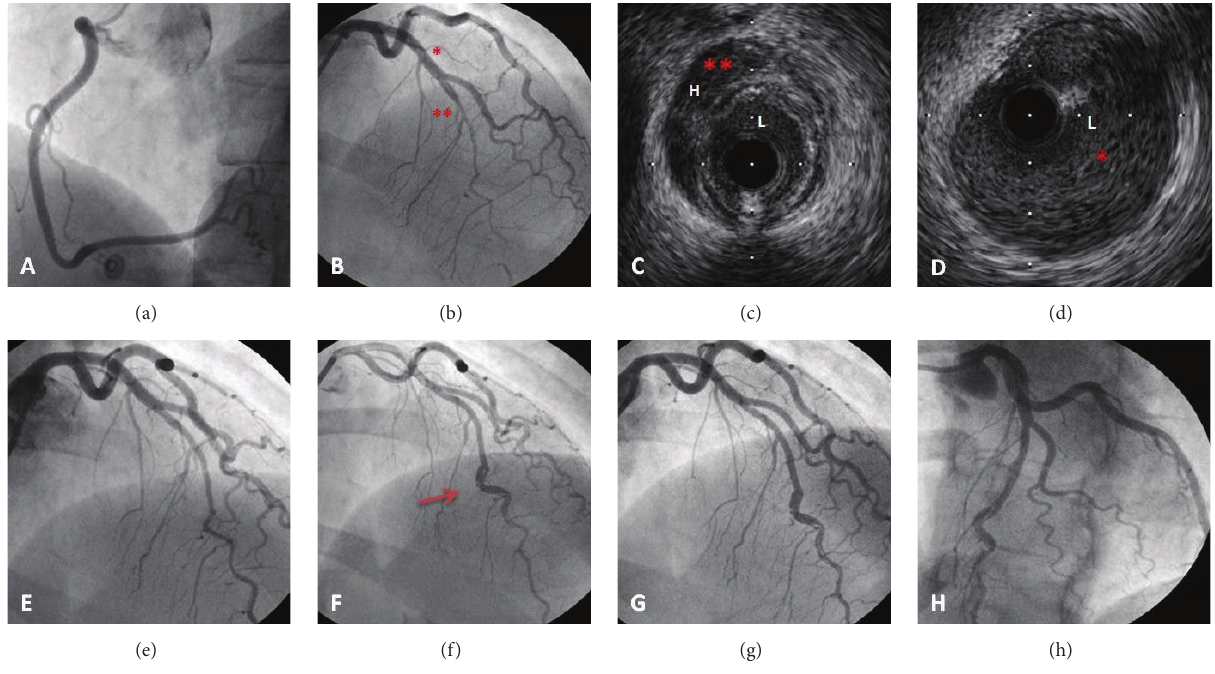
Figure 1: (a) Left anterior oblique (LAO) projection showing a favourable angiographic appearance of the RCA. (b) Right anterior oblique (RAO) cranial projection showing a long tubular stenosis of the mid-LAD, with abrupt demarcation ( ∗∗ ) from normal proximal segments ( ∗ ), which did not respond to intracoronary nitroglycerine. (c) IVUS examination showed near-circumferential hematoma (H) extending deep into the media and reducing the lumen (L). No atheroma was visualised. (d) IVUS examination of the proximal segments revealed normal vessel appearance and preserved lumen (L) caliber. (e) Final angiographic appearance of the mid-LAD, in RAO cranial projection. (f–h) At 6-month follow-up, RAO cranial projection of mid-LAD showing good coronary flow but with still evidence of significant vessel dissection in its distal